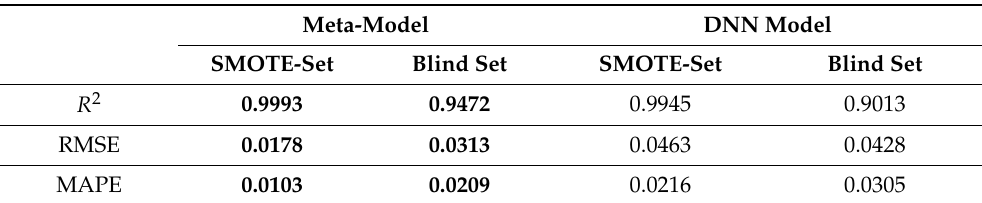
Table 9. Comparison of the statistical measures for the performance of the meta-model and DNN model against the SMOTE-set and blind